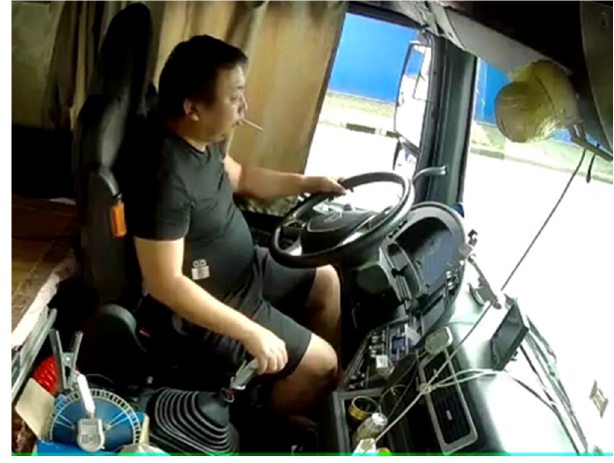
Figure 2. Superimposed posture of one-handed driving, smoking, manipulating gear.